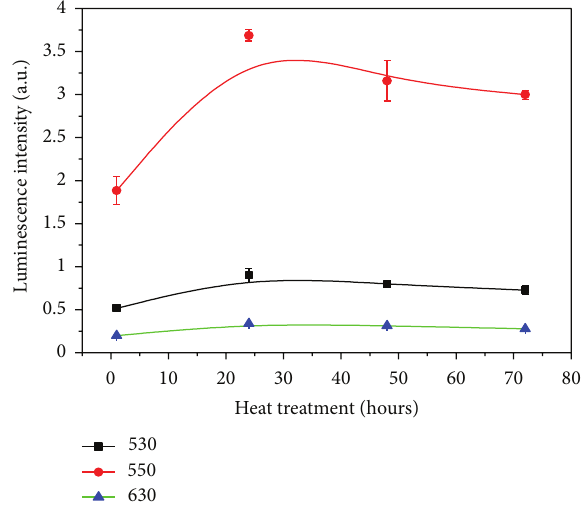
Figure 16: Dependence of the upconverted signals on the heat treatment corresponding to 2 H 11/2 → 4 I 15/2 and 4 F 9/2 → 4 I 15/2 transitions